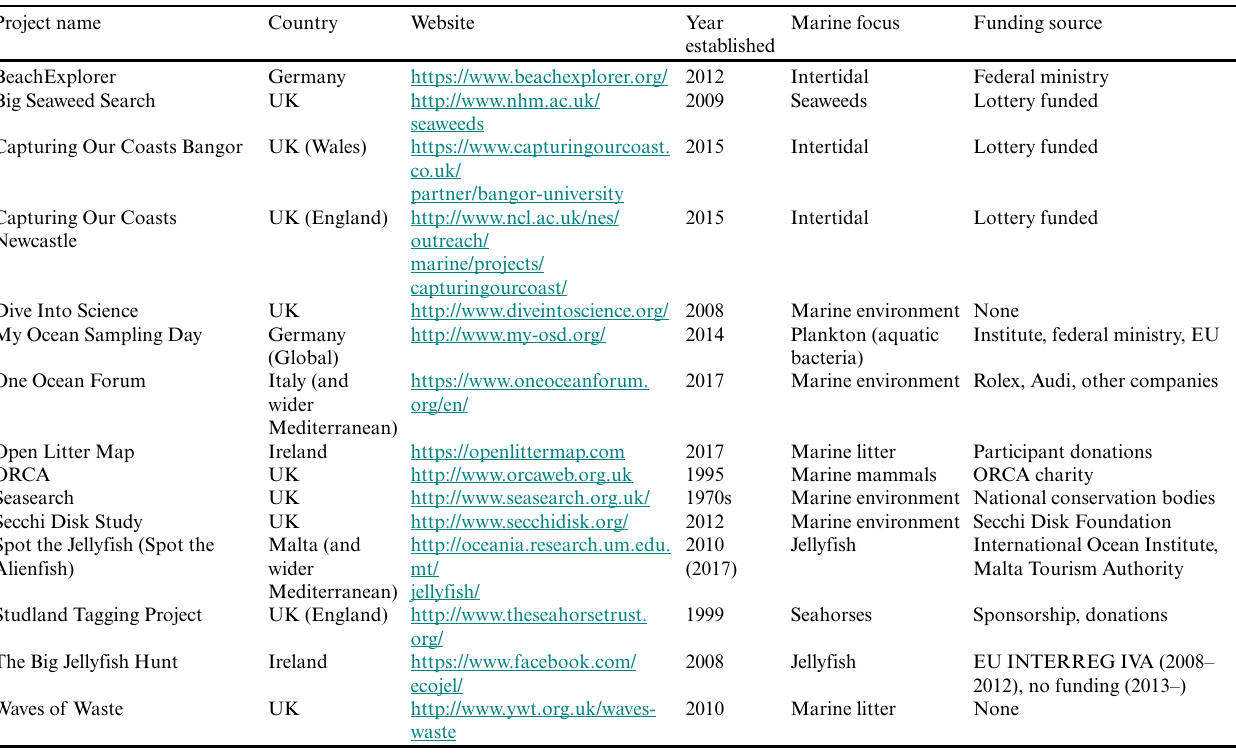
Table 2. Overview of the 15 marine citizen science projects for which we obtained interviews. These projects represented six countries, had varying levels of establishment (i.e., ranging from very new to long established), had different objectives with regard to marine research and conservation, and were supported by different funding